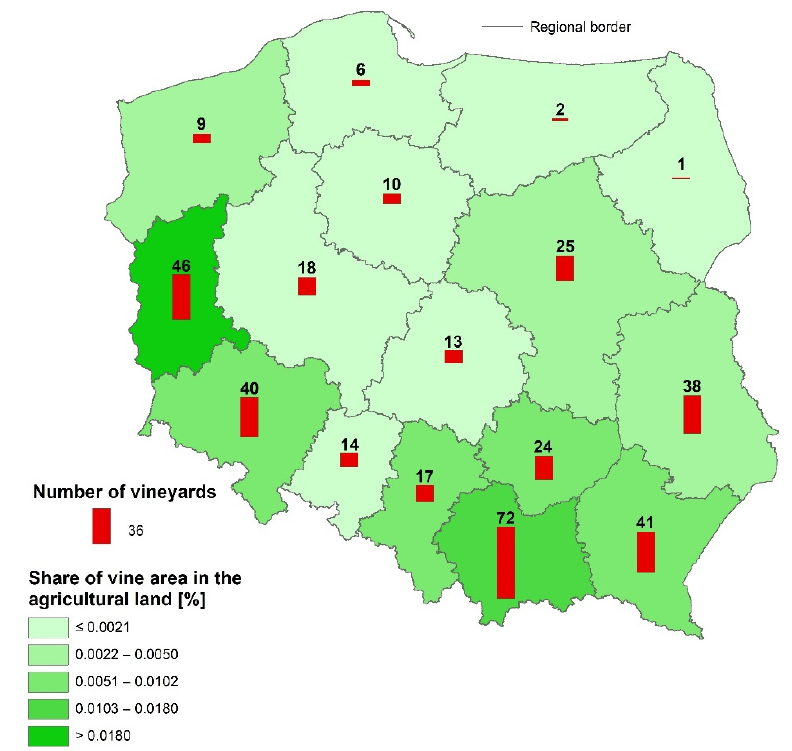
Figure 3. Number of vineyards and share of vine area in the agricultural land by regions in Poland in 2021. Source: own study based on the data from National Support Centre for Agriculture. Until recently, the Lubuskie Region had been considered to be the most northerly compact wine region, both in Europe and in the world where grapevines are grown on an industrial scale [40]. However, today this line has been moved. In 2021, 376 vineyards were registered in the records of wine producers in Poland; most of them in the following regions: Małopolskie (72), Lubuskie (46) and Podkarpackie (41). Their total area is about 626 ha, with the highest share of vineyards in the total area of agricultural land belonging to the Lubuskie Province. It is in this region that wine making has had a relatively uninterrupted tradition for over 800 years now. Despite the turbulent historical background of this area and the repeated changes in the population inhabiting the region, viticulture has become an inherent feature of this land, and presently we can observe the beginning of the intensifying activities within the fourth development